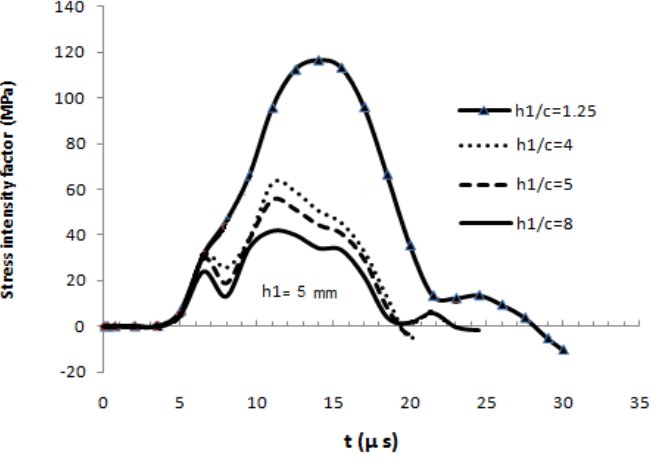
Figure 7. DSIF curves versus time of PZT-5H composite.